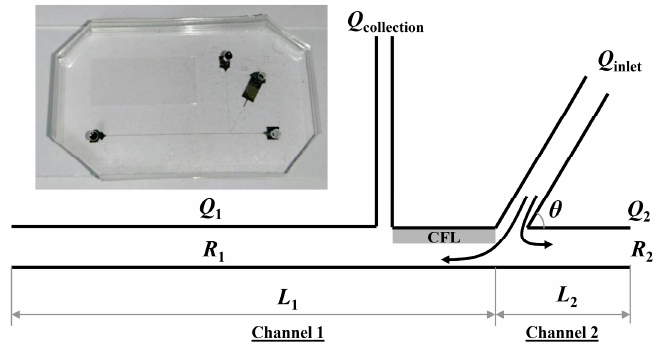
Figure 3. Schematic diagram of the microchannel design for plasma separation. The gray area indicates the region where CFL width measurements were performed. Due to the difference in flow resistance in channels 1 and 2, RBC flow was biased towards the channel with the higher flow rate, enhancing the CFL formation in the collection channel. The inset shows a photograph of the fabricated microchannel.